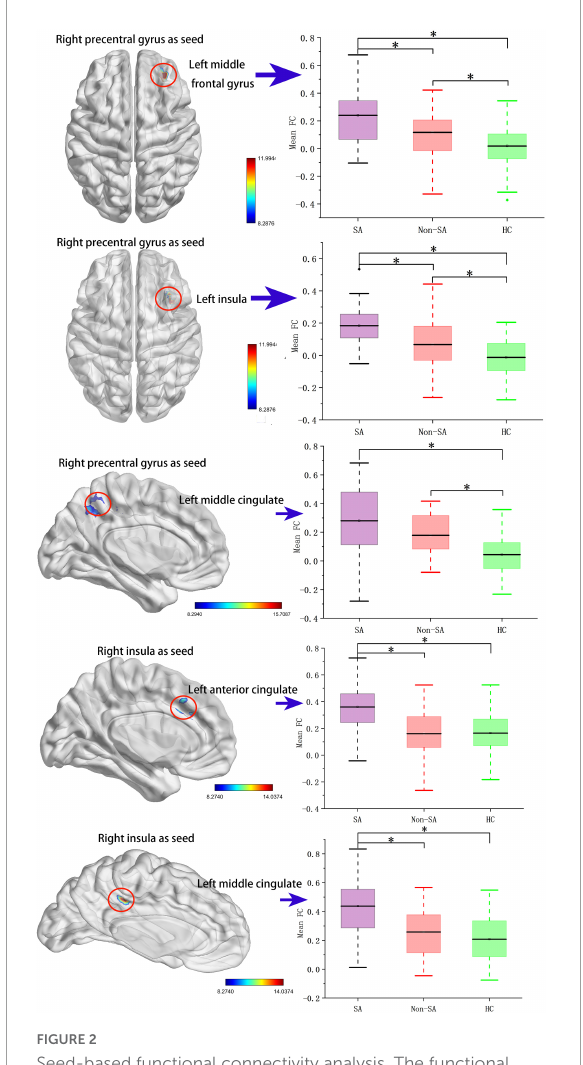
FIGURE2 Seed-based functional connectivity analysis. The functional connectivity between the right precentral gyrus and the left middle frontal gyrus, left insula, and left middle cingulate cortex, and the functional connectivity between the right insula and left anterior cingulate cortex and left middle cingulate cortex are significant different among SA, non-SA, and HC groups, Monte Carlo simulation corrected. “ ∗ ” indicates statistically